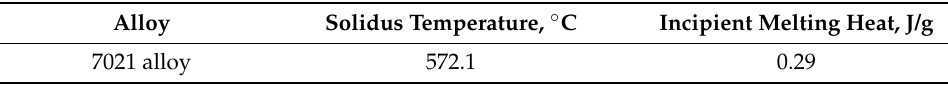
Figure 1. DSC curves for 7021 alloy after homogenization in different conditions. Table 3. DSC test results of homogenized 7021 alloy [22]. Alloy Solidus Temperature, ◦ C Incipient Melting Heat,